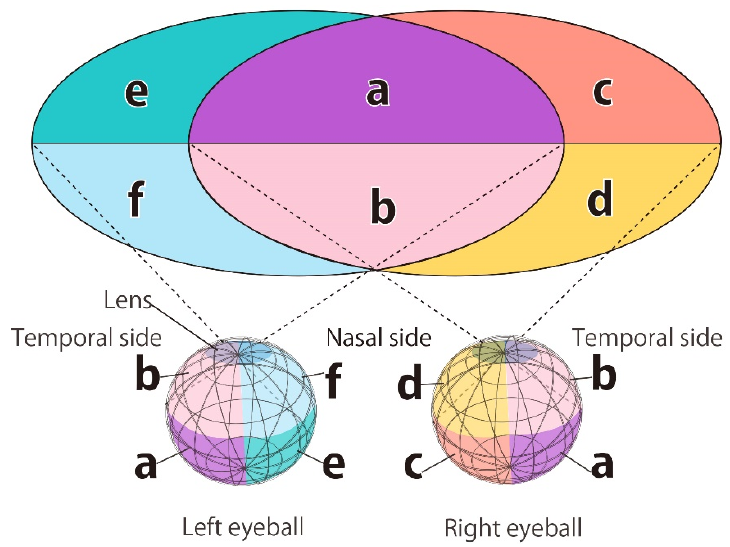
Figure 2. The relation between a human’s visual field and the retinal area in the